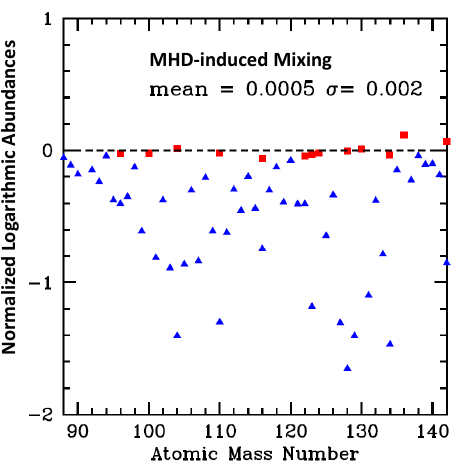
Figure 2. Predictions of the solar fractional abundance distribution from the models of stellar and galactic s -process nucleosynthesis discussed in the text, for nuclei from 88 Sr to 142 Ce.